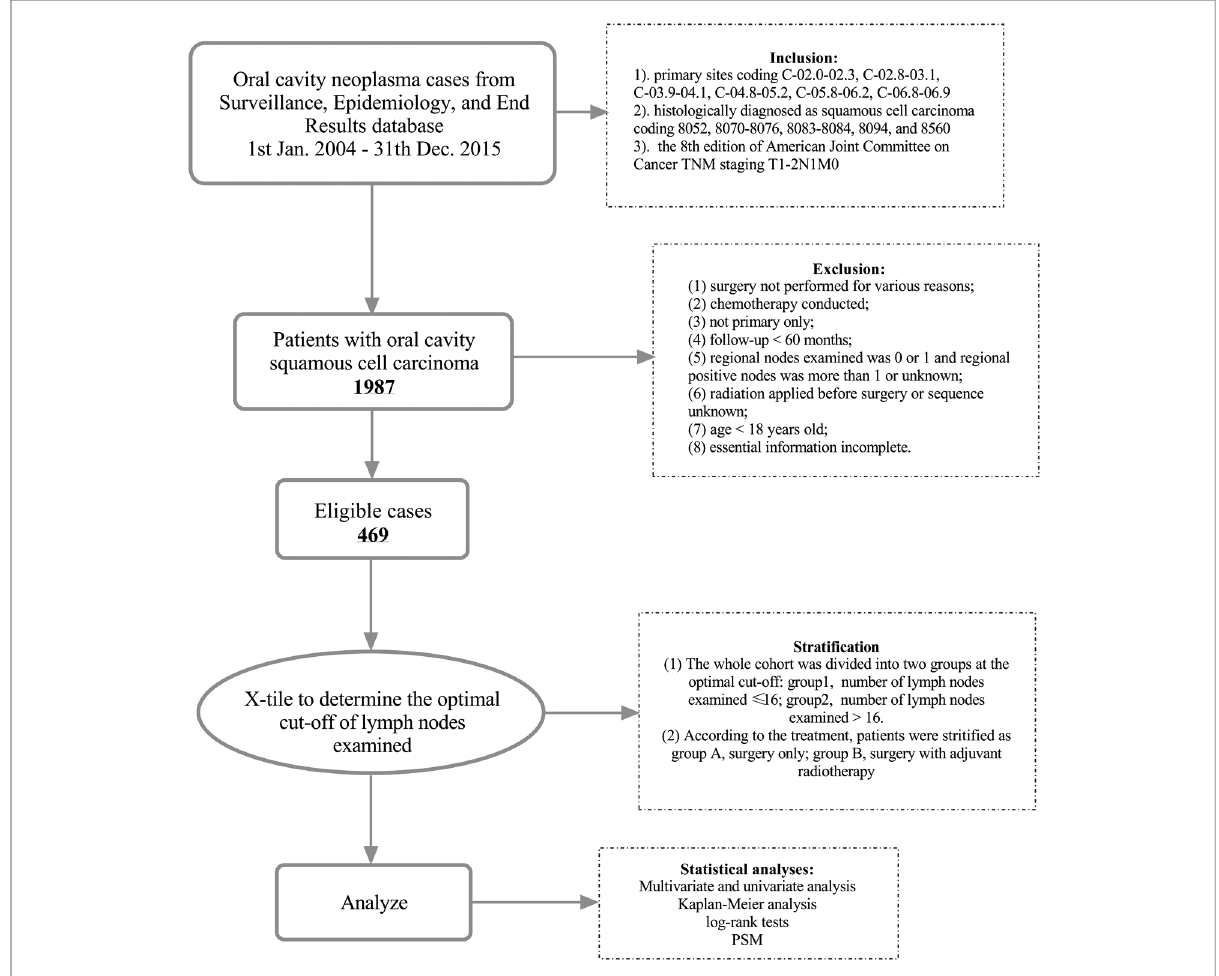
FIGURE 1 Diagram of the patient screening process in the Surveillance Epidemiology and End Results